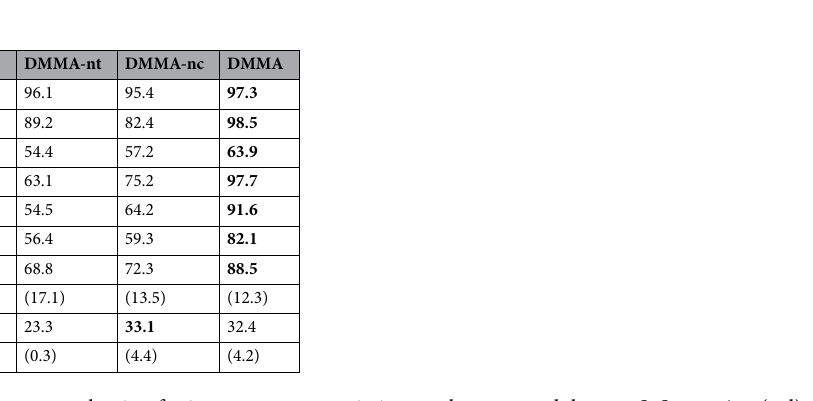
Table 4. Performance evaluation for inter-camera association on the proposed dataset. S, Scene; Ave (std), average of all scenes and (standard deviation); MCTA, Multi-Camera object Tracking Accuracy 12 ( bold : best results).